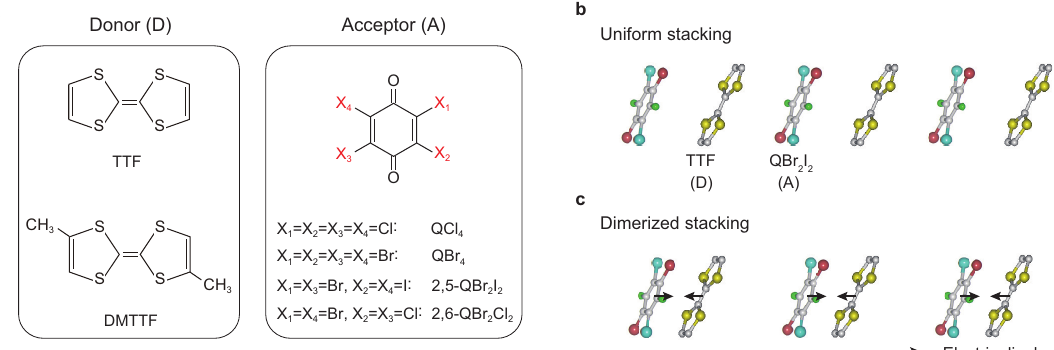
Figure 1. ( a ) Chemical forms of donor and acceptor molecules that appear in this article. ( b,c ) Schematic diagrams of the structure of the donor–acceptor mixed stack: with a uniform spacing ( b ) and in a dimerized state ( c ). Small arrows in ( c ) indicate the shifts in the molecules that occur upon